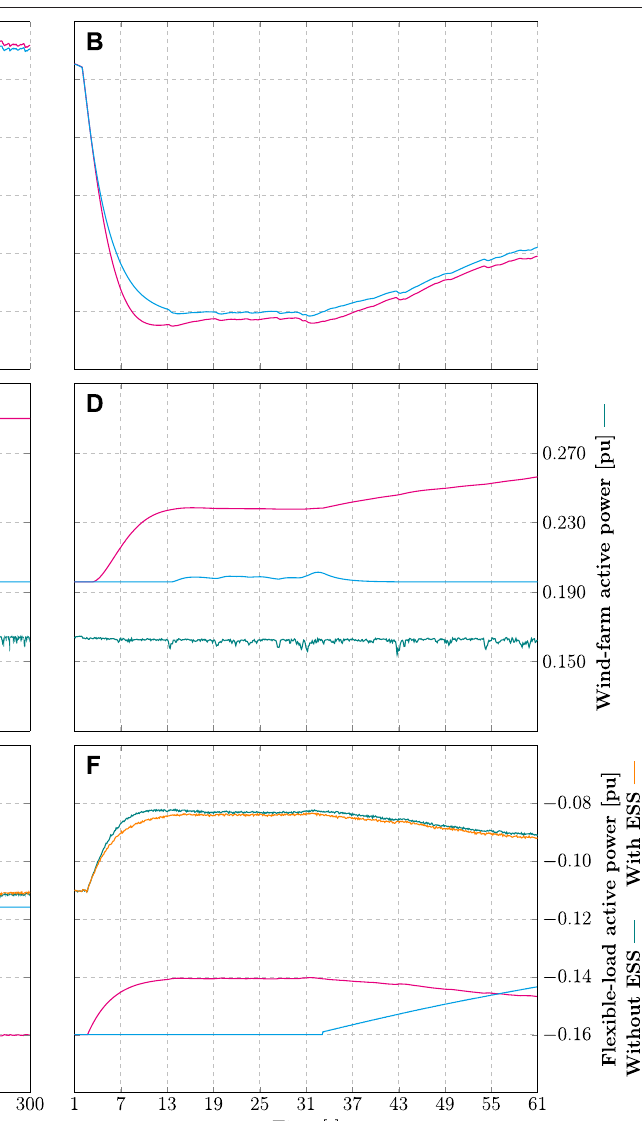
Frontiers in Energy Research |